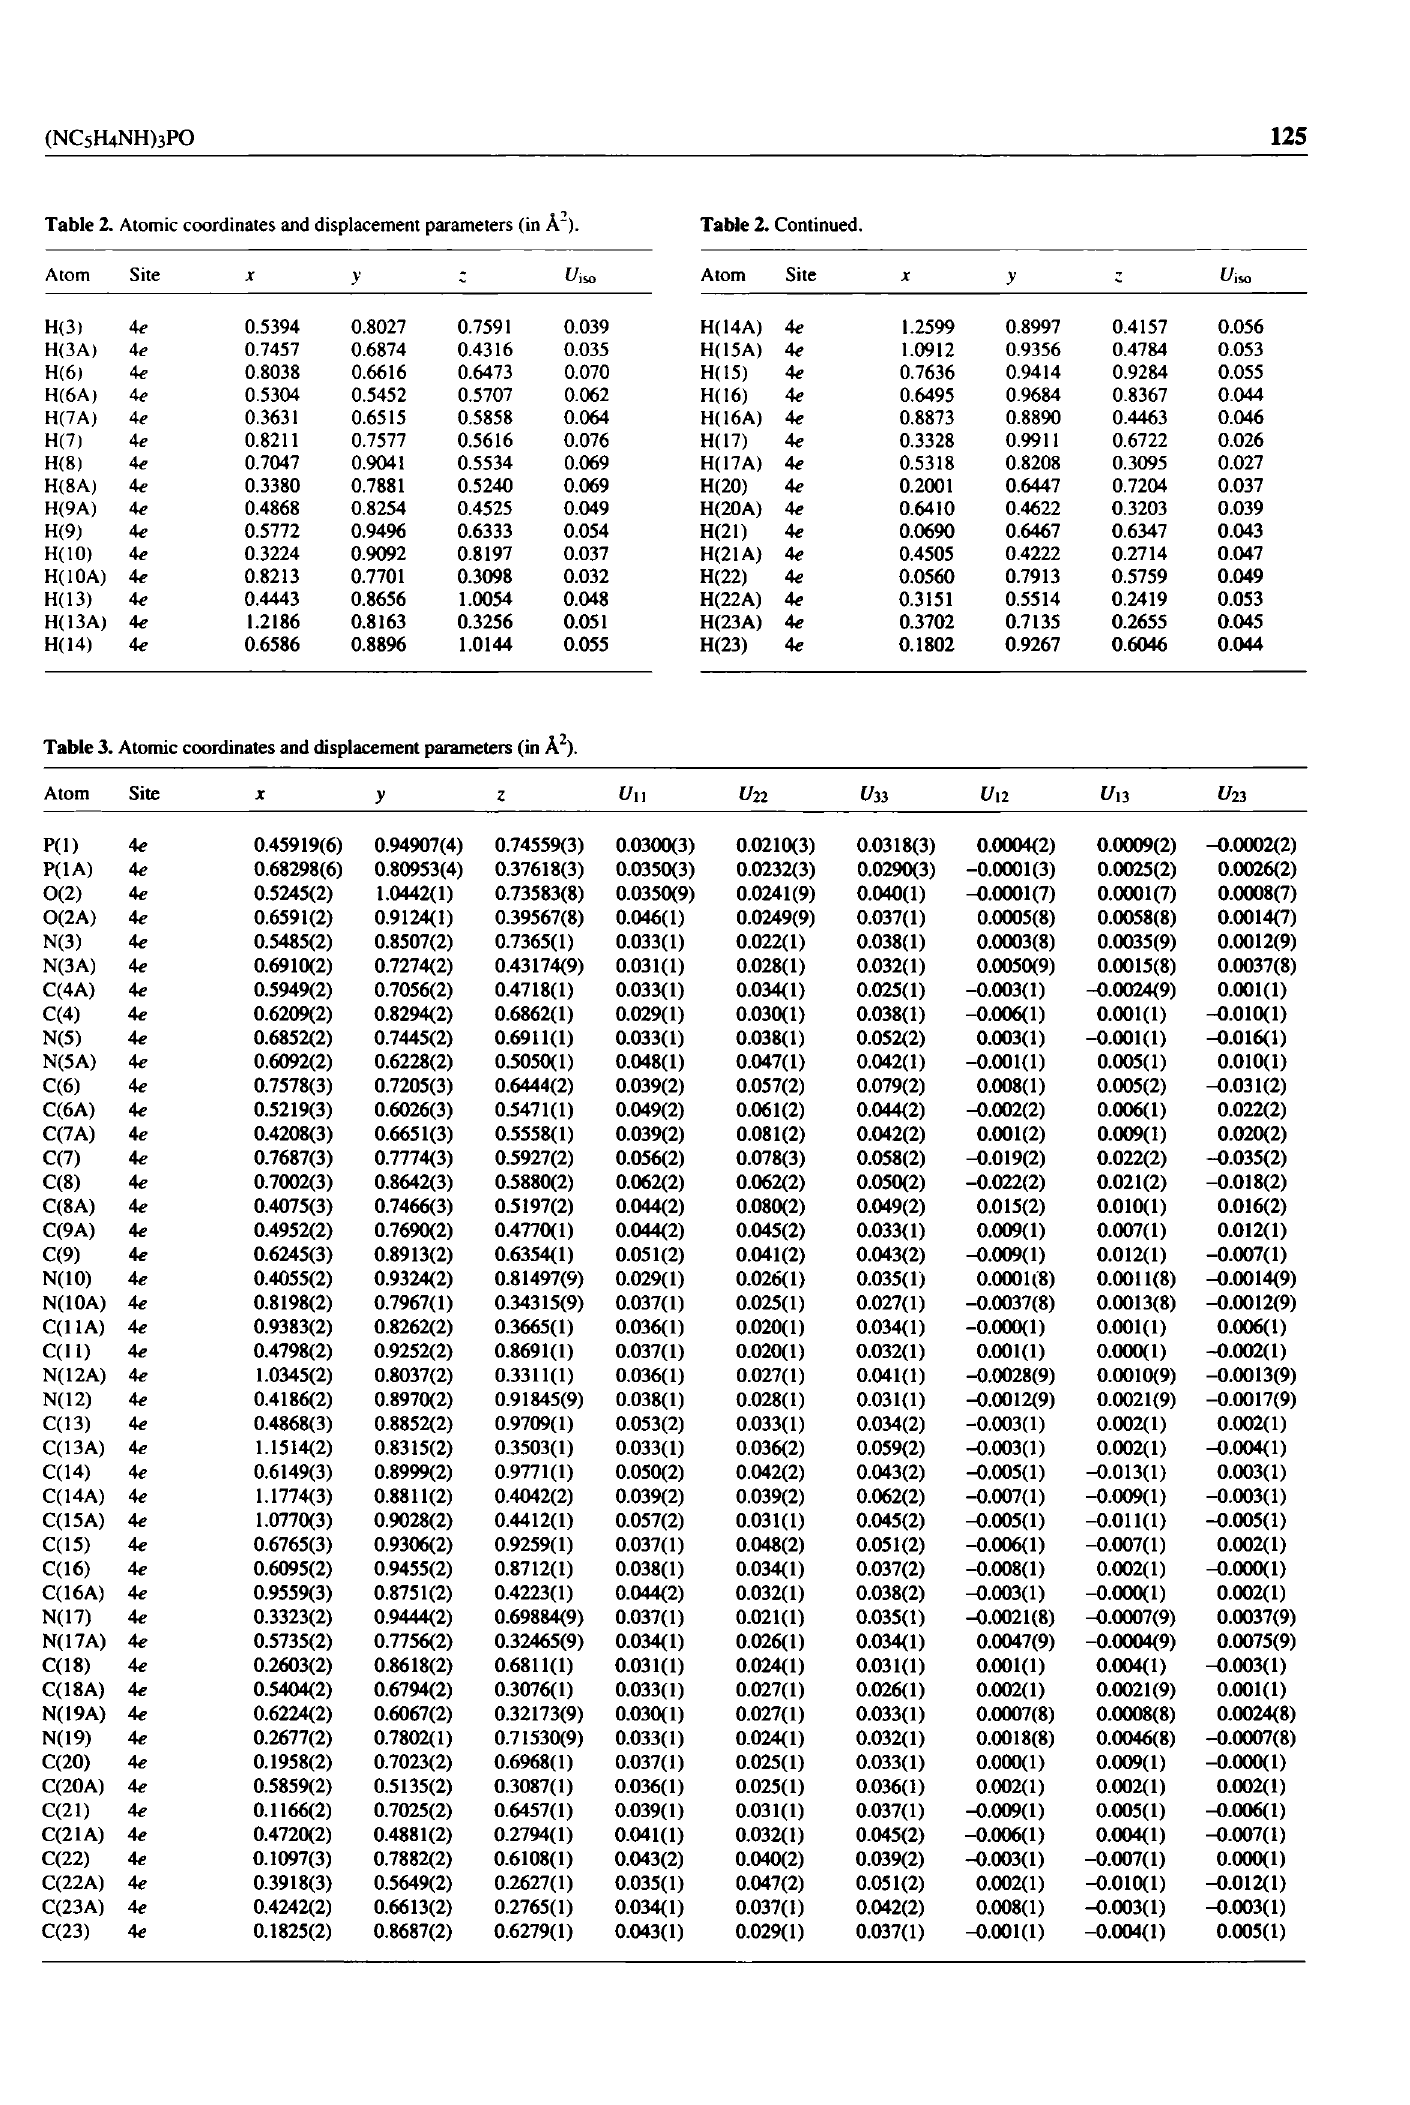
Table 3. Atomic coordinates and displacement parameters (in Ä 2